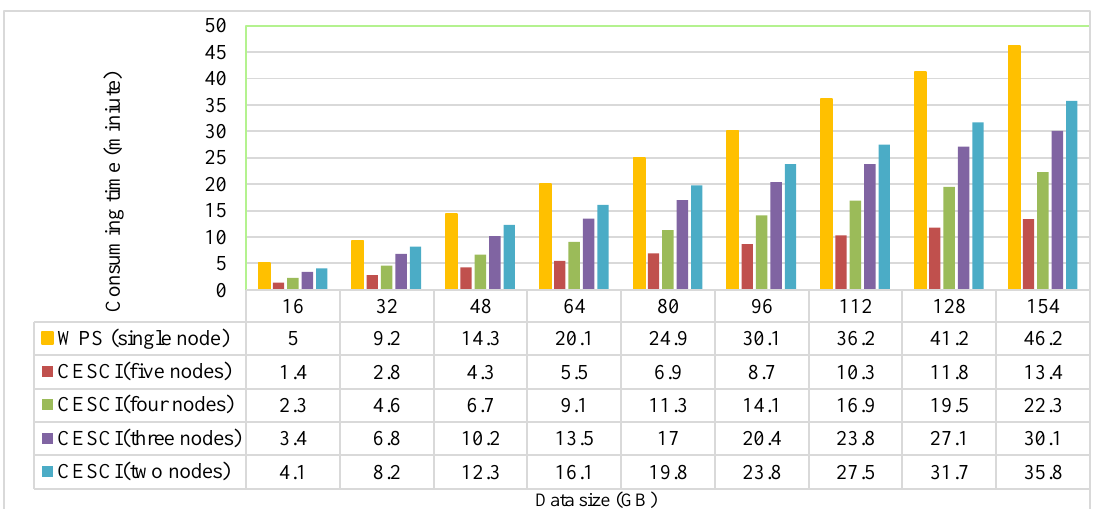
Figure 5. The MapReduce process used to map the NDVI in Hubei province.